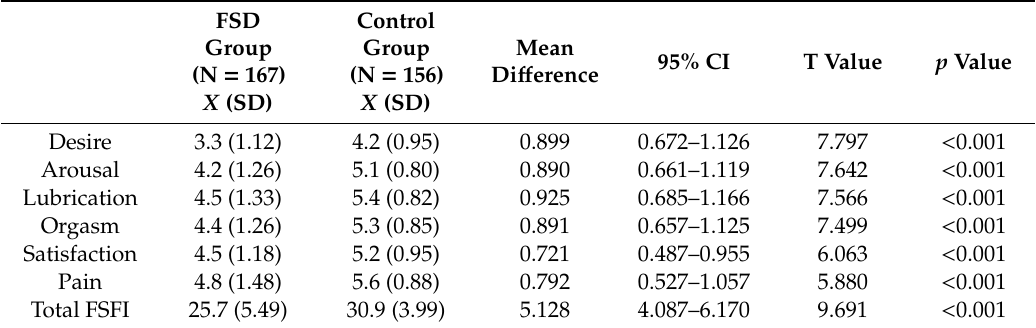
Table 6. Discriminant construct validity: correlation of FSFI domains scores between cases and control group (Paired t -test).